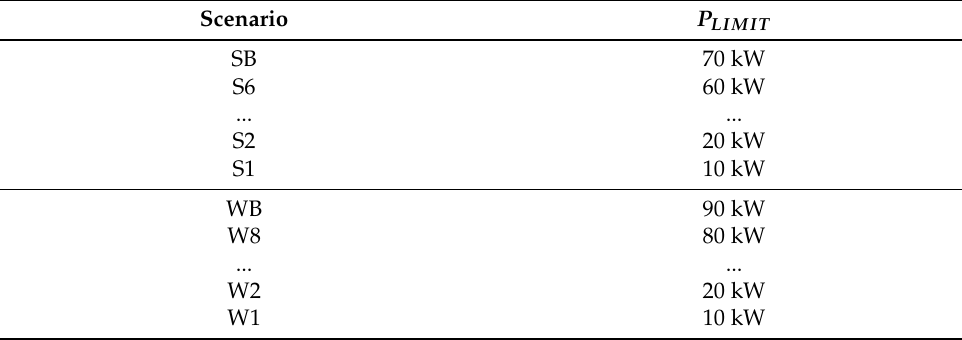
Table 3. Scenarios defined for the case example.